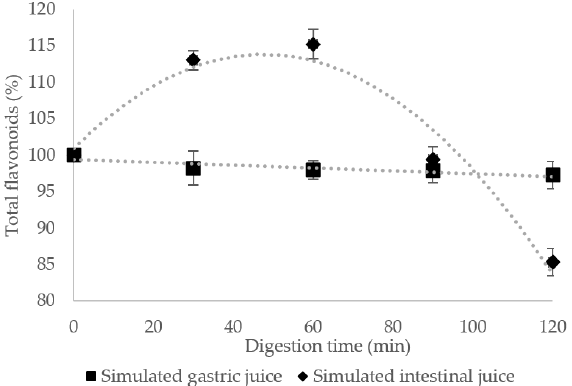
Figure 1. Total flavonoids release from the co-microencapsulated powder during in vitro digestion in simulated gastric and intestinal juices. Data shown are averages of triplicate samples. Error bars on the chart represent standard deviations.